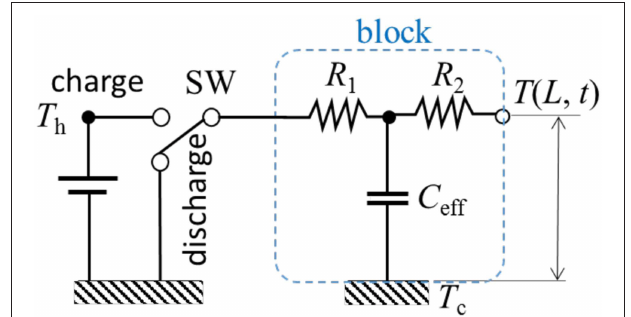
TABLE 2 | Material properties of selected solids.